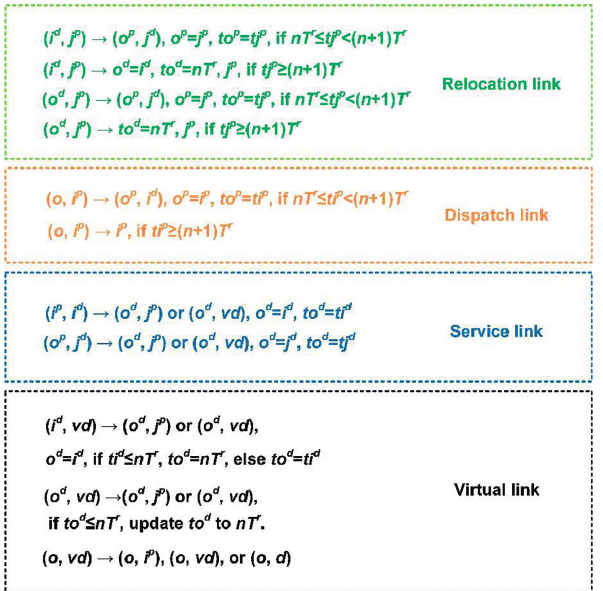
Figure 5: Processing scheme for unfinished